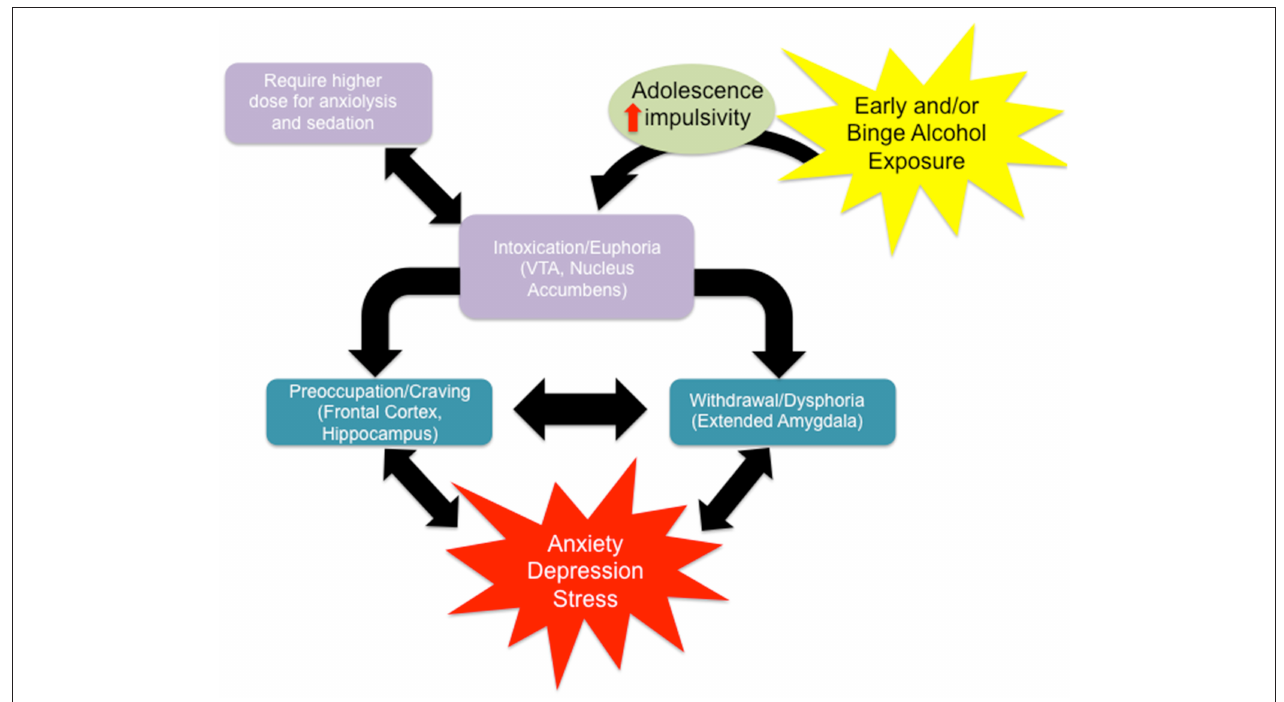
FIGURE 1 | Alcohol use disorder is characterized by the classical pattern of addiction, namely a cycle from a state of euphoria during alcohol intoxication to that of dysphoria during alcohol withdrawal to one of craving in the absence of acute intoxication. Craving, with or without withdrawal symptoms, is characterized by preoccupation with obtaining alcohol and anticipation of alcohol use, leading to relapse and a return to the intoxicated state. Certain individual clinical characteristics or psychosocial factors can exacerbate this cycle, driving alcohol use and addiction. For example, impulsivity renders an individual more sensitive to the immediate, rewarding effects of alcohol intake, with minimization of any longer term negative consequences, driving alcohol intake. Adolescence alone is characterized by an increased sensitivity to the rewarding effects of alcohol with a protection from the negative effects relative to aged counterparts, driving alcohol intake for this group. Adolescence is often characterized by impulsivity and together these characteristics facilitate alcohol intake. Also they require higher doses of ethanol to produce anxiolysis and sedation. Withdrawal from alcohol can both induce anxiety or depression symptoms and be worsened by comorbid mood disorders. Anxiety or depression can separately be exacerbated by other stressors, acute or chronic, and has been shown to be increased over the long term by environmental insults during development (early adversity). Stress and/or mood decompensation can also, in the absence of withdrawal dysphoria, directly stimulate craving and relapse, driving the cycle of addiction at either